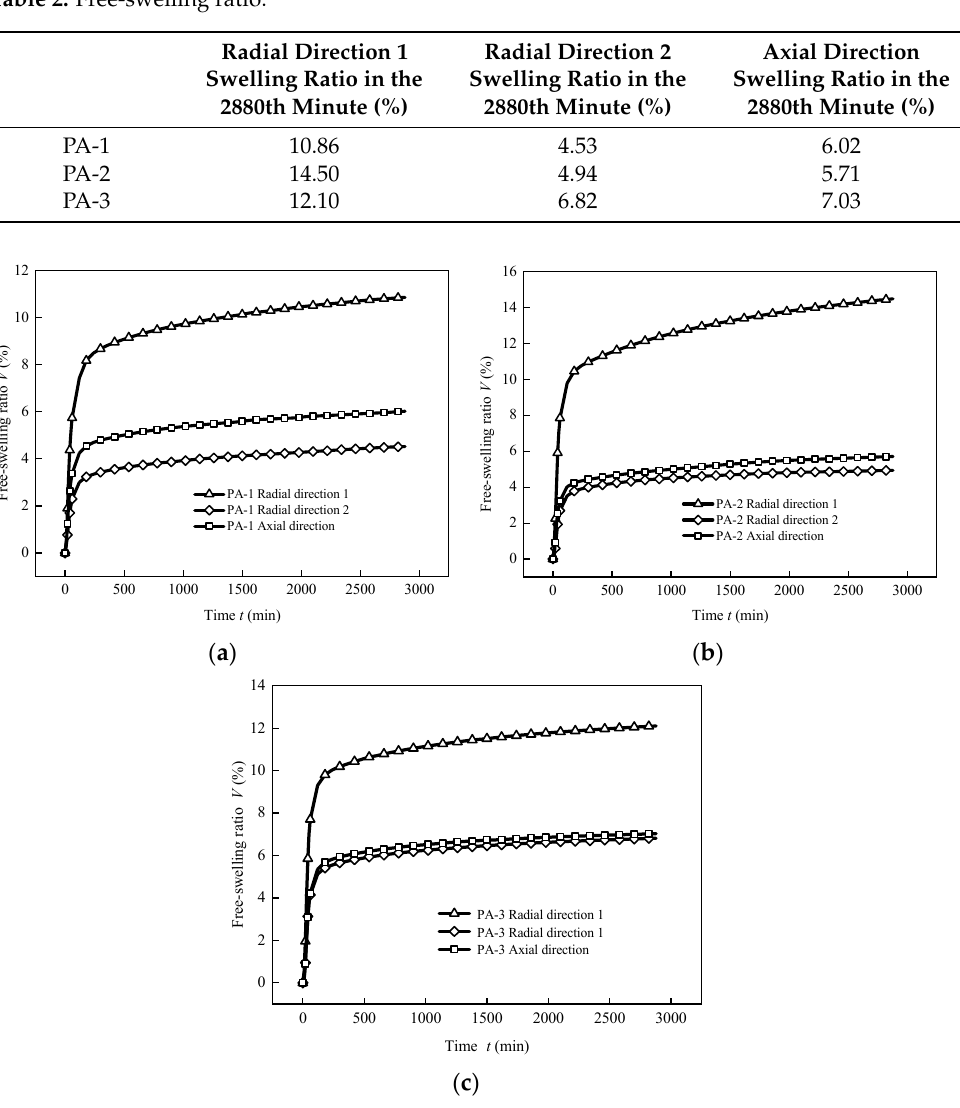
Figure 7. Free ‐ swelling ratio: ( a ) Sample 1; ( b ) Sample 2; ( c ) Sample 3. Figure 7. Free-swelling ratio: ( a ) Sample 1; ( b ) Sample 2; ( c ) Sample